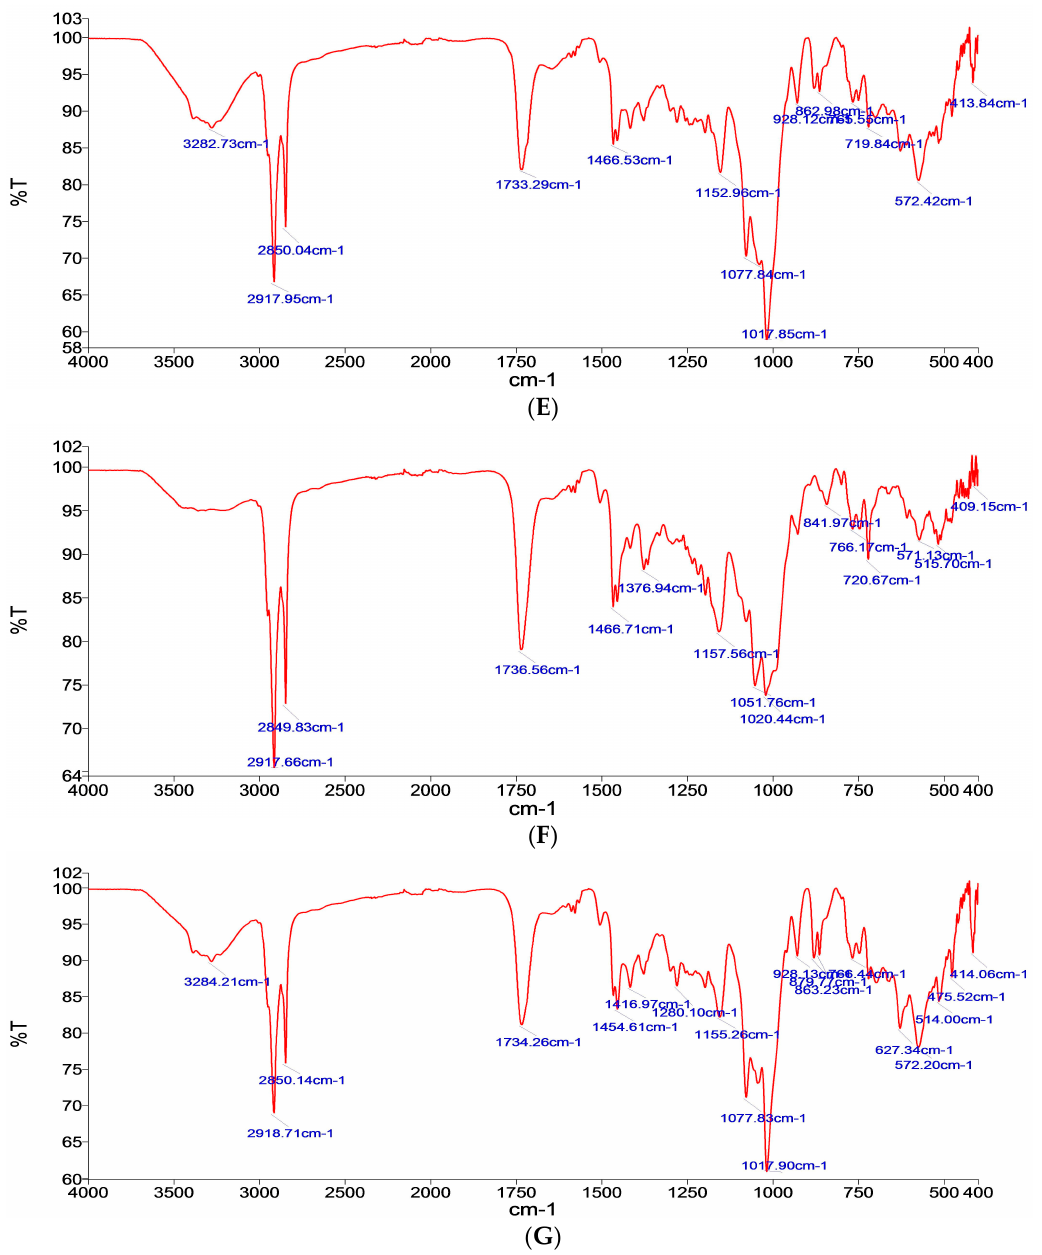
Figure 1. Fourier Transform Infrared FTIR Spectra of ( A ) pure drug, ( B ) glucose carrier, ( C ) maltodextrin carrier, ( D ) mannitol carrier, ( E ) formulation with glucose as a carrier (FN1), ( F ) formula with maltodextrin as a carrier (FN2), and ( G ) formula with mannitol as a carrier (FN3) .